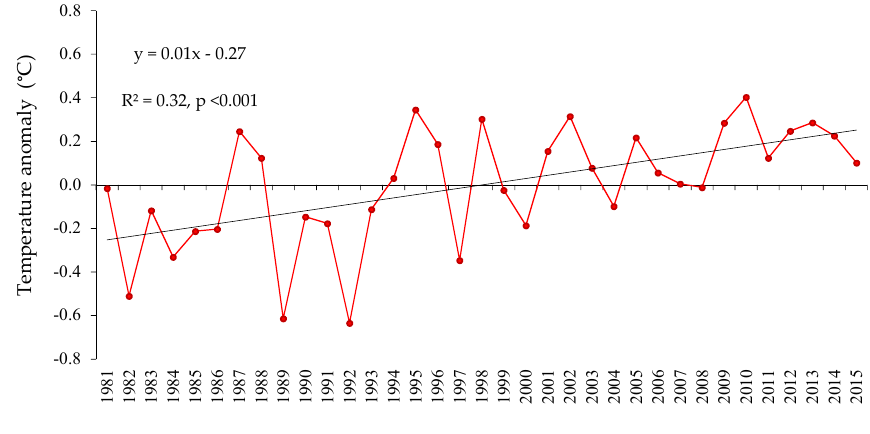
Figure 2. Observed annual maximum temperature anomalies in Myanmar during 1981–2015.